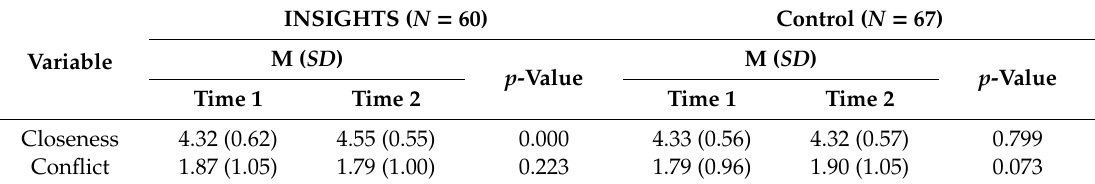
Table 4. Pre- and post-INSIGHTS intervention descriptive statistics for teacher–child relationships.